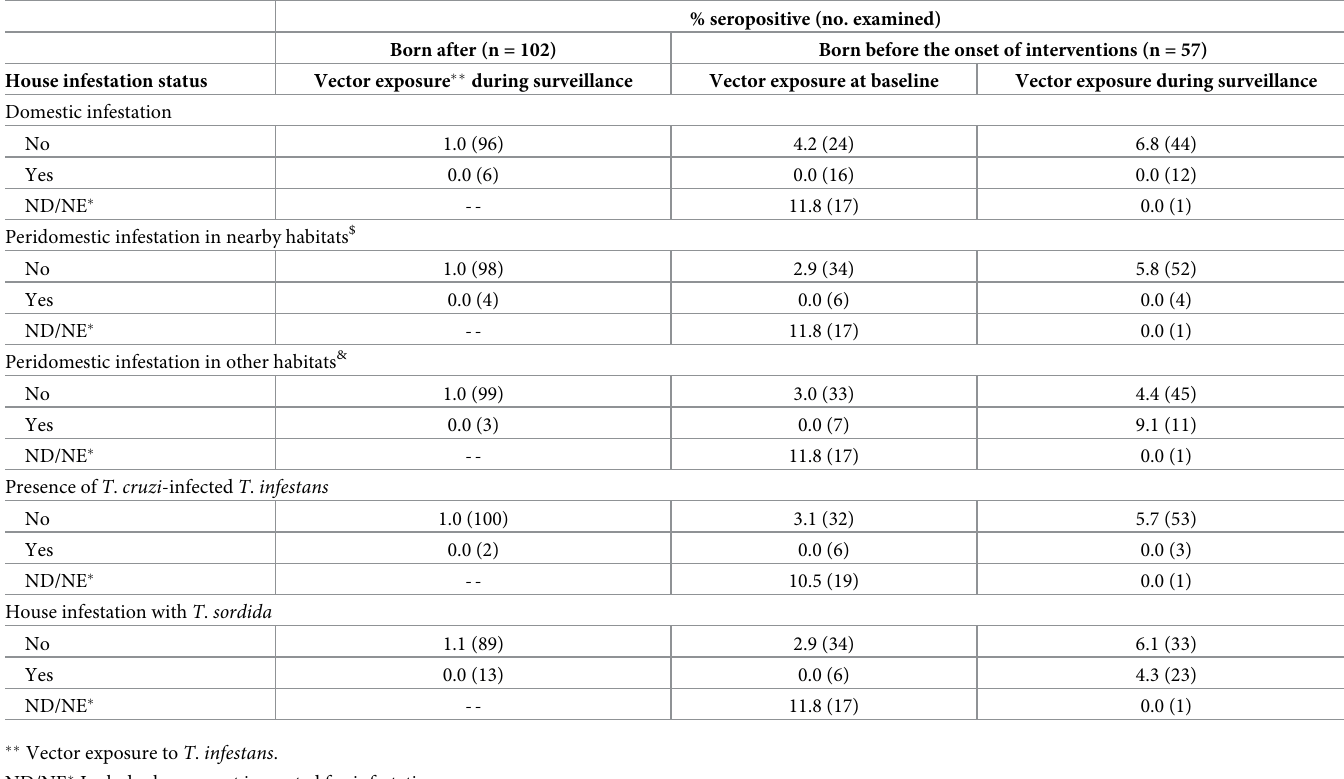
Table 2. Seroprevalence of Trypanosoma cruzi infection in children < 16 years of age according to observed exposure to Triatoma infestans (unless otherwise noted) during the vector surveillance phase, Pampa del Indio, Chaco, 2008–2016. % seropositive (no. examined) Born after (n = 102) Born before the onset of interventions (n = 57) House infestation status Vector exposure �� during surveillance Vector exposure at baseline Vector exposure during surveillance Domestic infestation